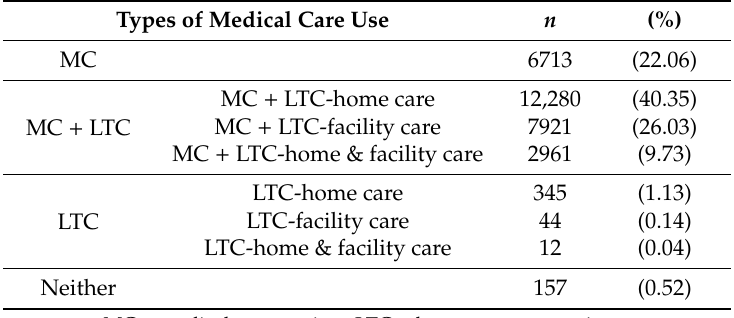
Table 1. Pattern of medical care use of long-term care insurance (LTCI) beneficiaries.